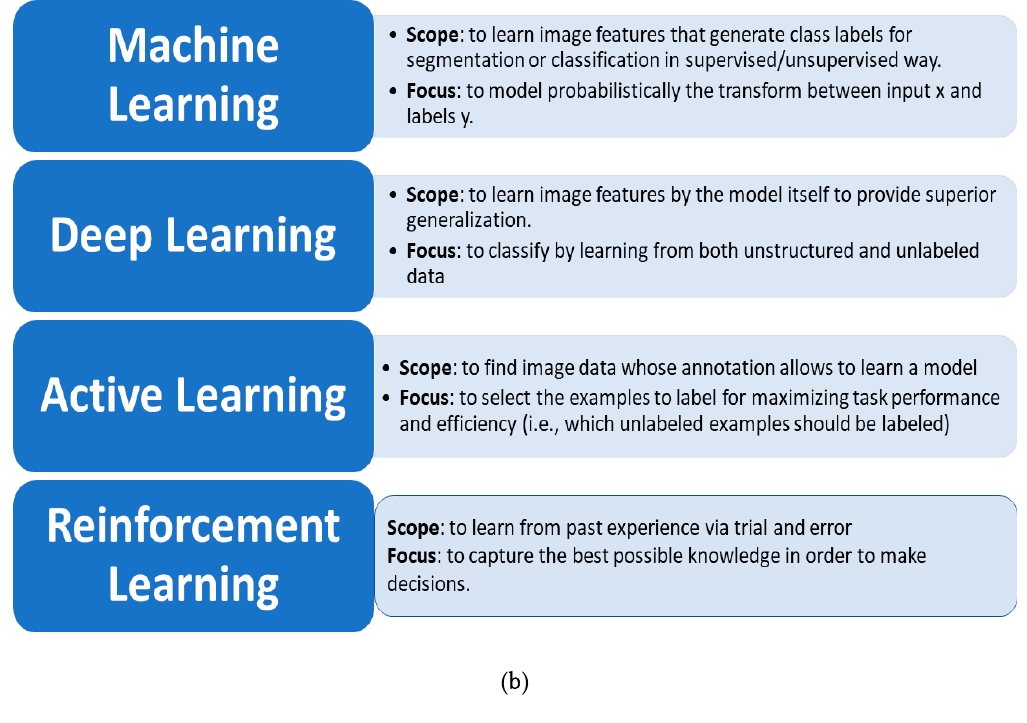
Figure 1. Salient information about learning techniques. Methodological aspects ( a , top panel); Scope and focus ( b , bottom panel).